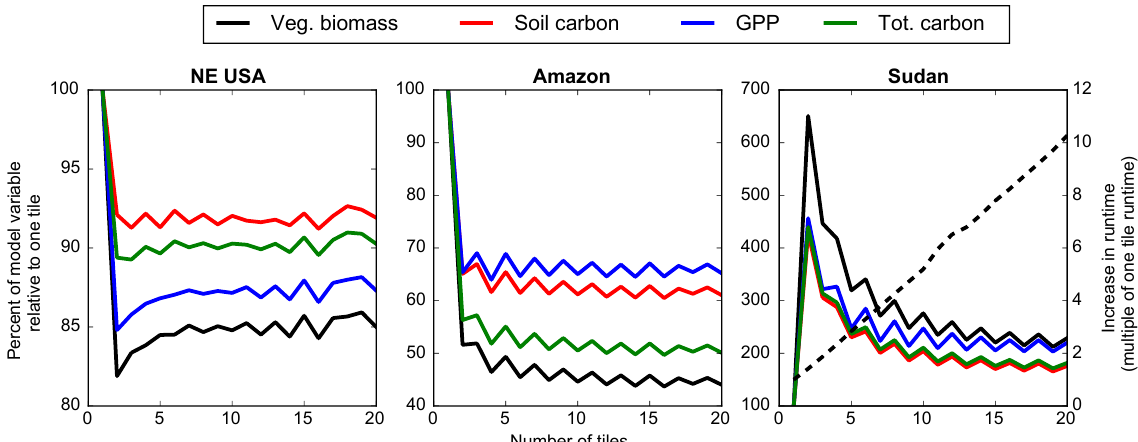
Figure 1. Sensitivity test of CLASS-CTEM to the number of tiles (clusters) for three test grid cells. The texture of each tile as the number of tiles increases is described in Sect. 3.1. GPP is gross primary productivity. All simulations were run until a new equilibrium state was established. The increase in runtime of the model is displayed as a dashed